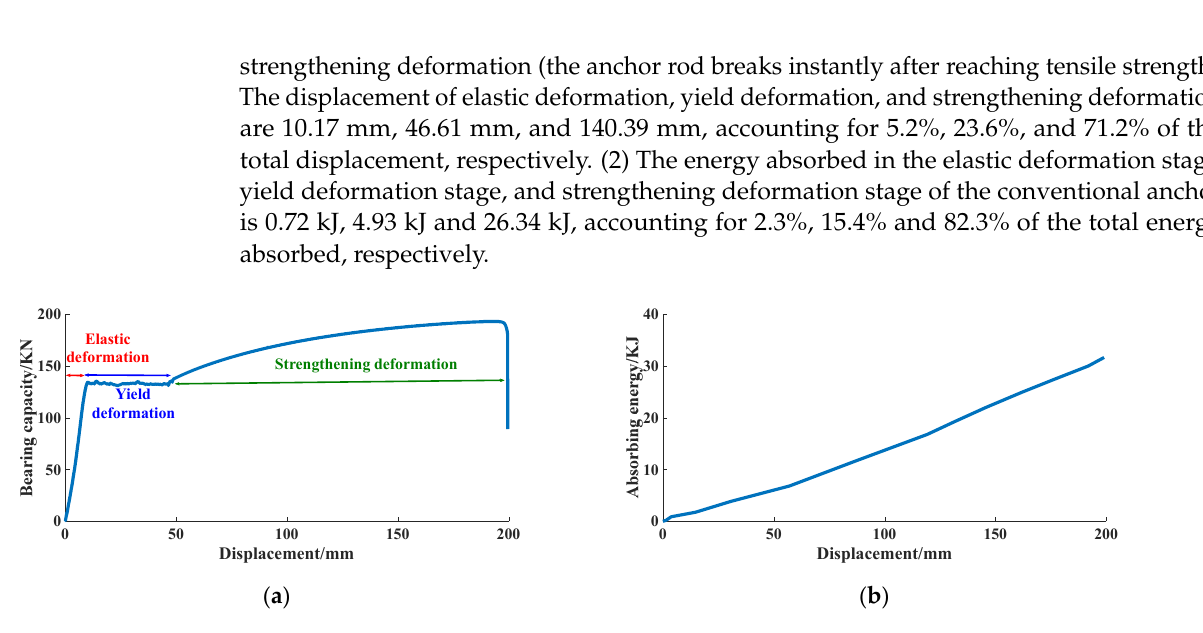
Figure 5. Mechanical property curves of conventional anchor rods ( a ) Bearing capacity-displacement curve; ( b ) Energy absorption characteristic curve.